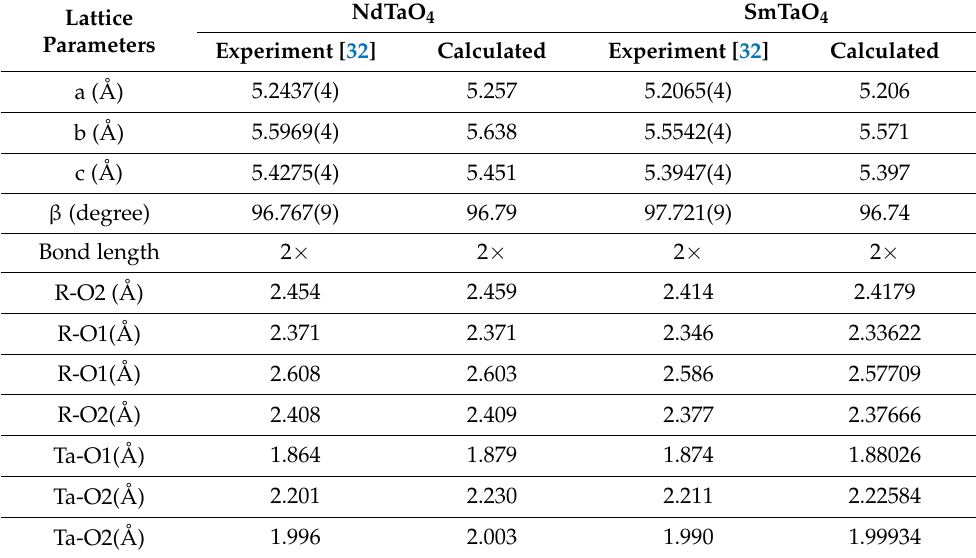
Table 1. Comparison of simulated ambient pressure lattice parameters and constituent bond lengths of NdTaO 4 and SmTaO 4 with previously reported experimental